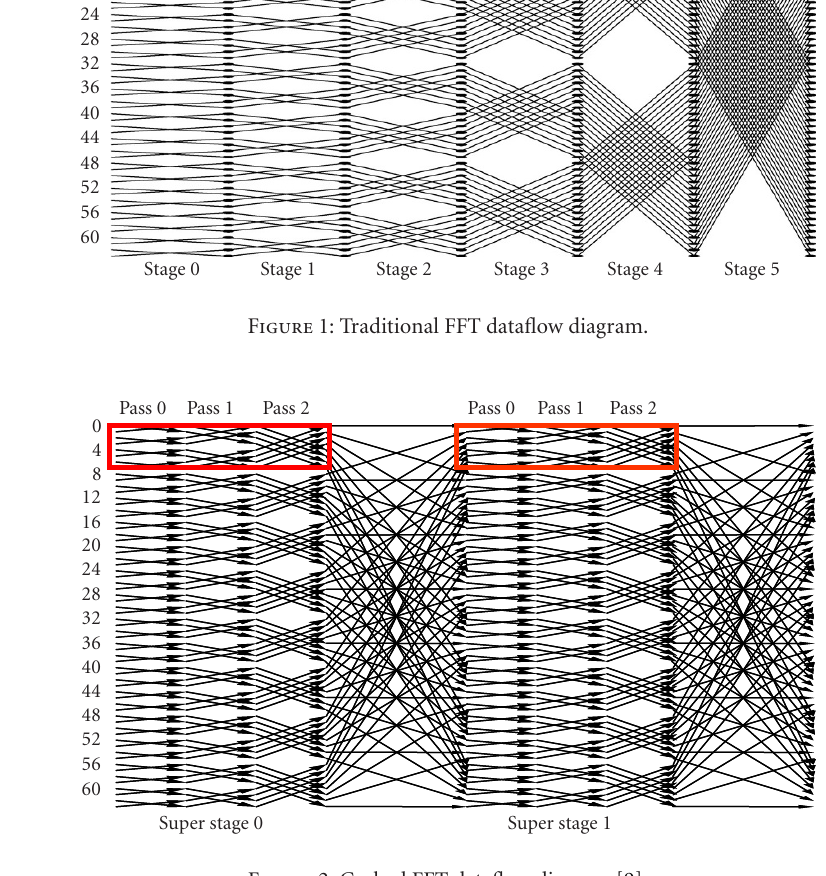
Figure 2: Cached FFT dataflow diagram [9].